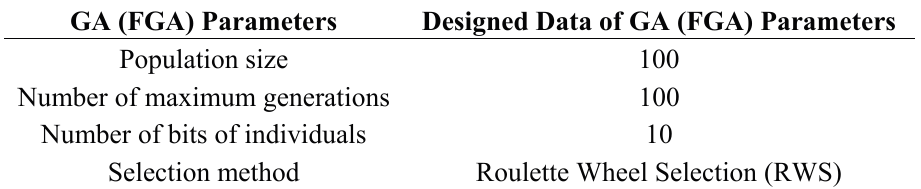
Table 1. GA (FGA) parameters of population and